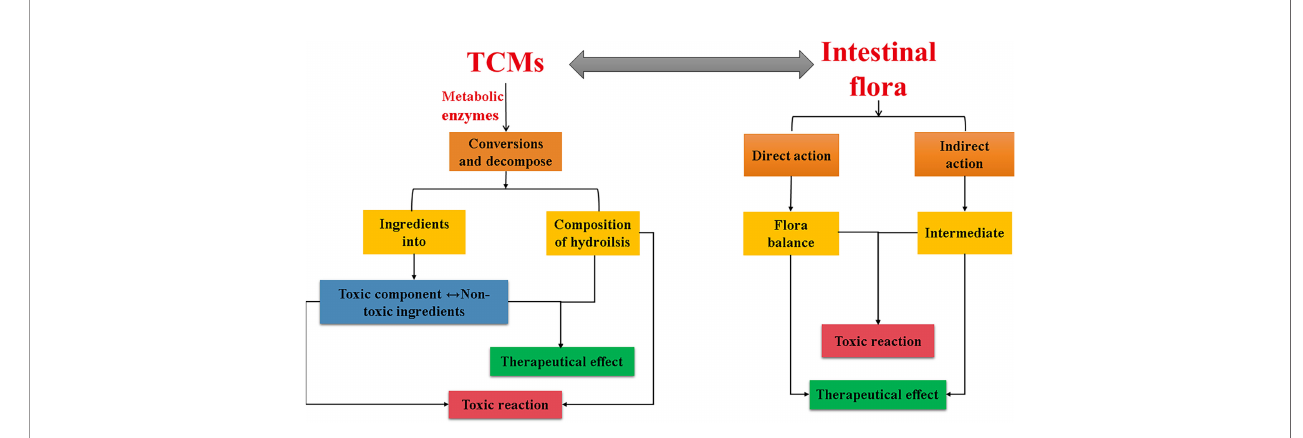
FIGURE 3 | Interaction between TCM and intestinal